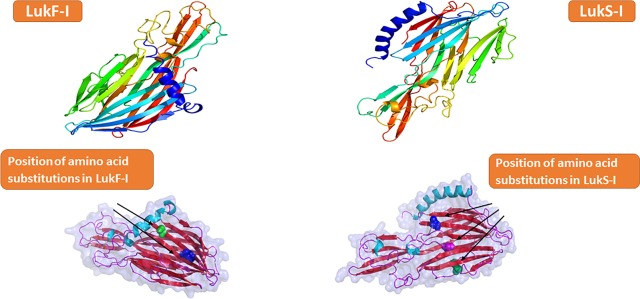
Ribbon representation of Wild-type and attenuated S. pseudintermedius LukS-I and LukF-I proteins.a, Color-ramped from the N terminus (blue) to the C terminus (red). The output structure was generated with Pymol.